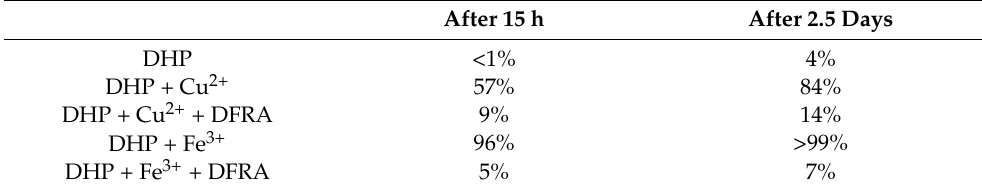
Table 3. The amount of oxidation products of DHP after the reaction with metal ions in the presence of hydrogen